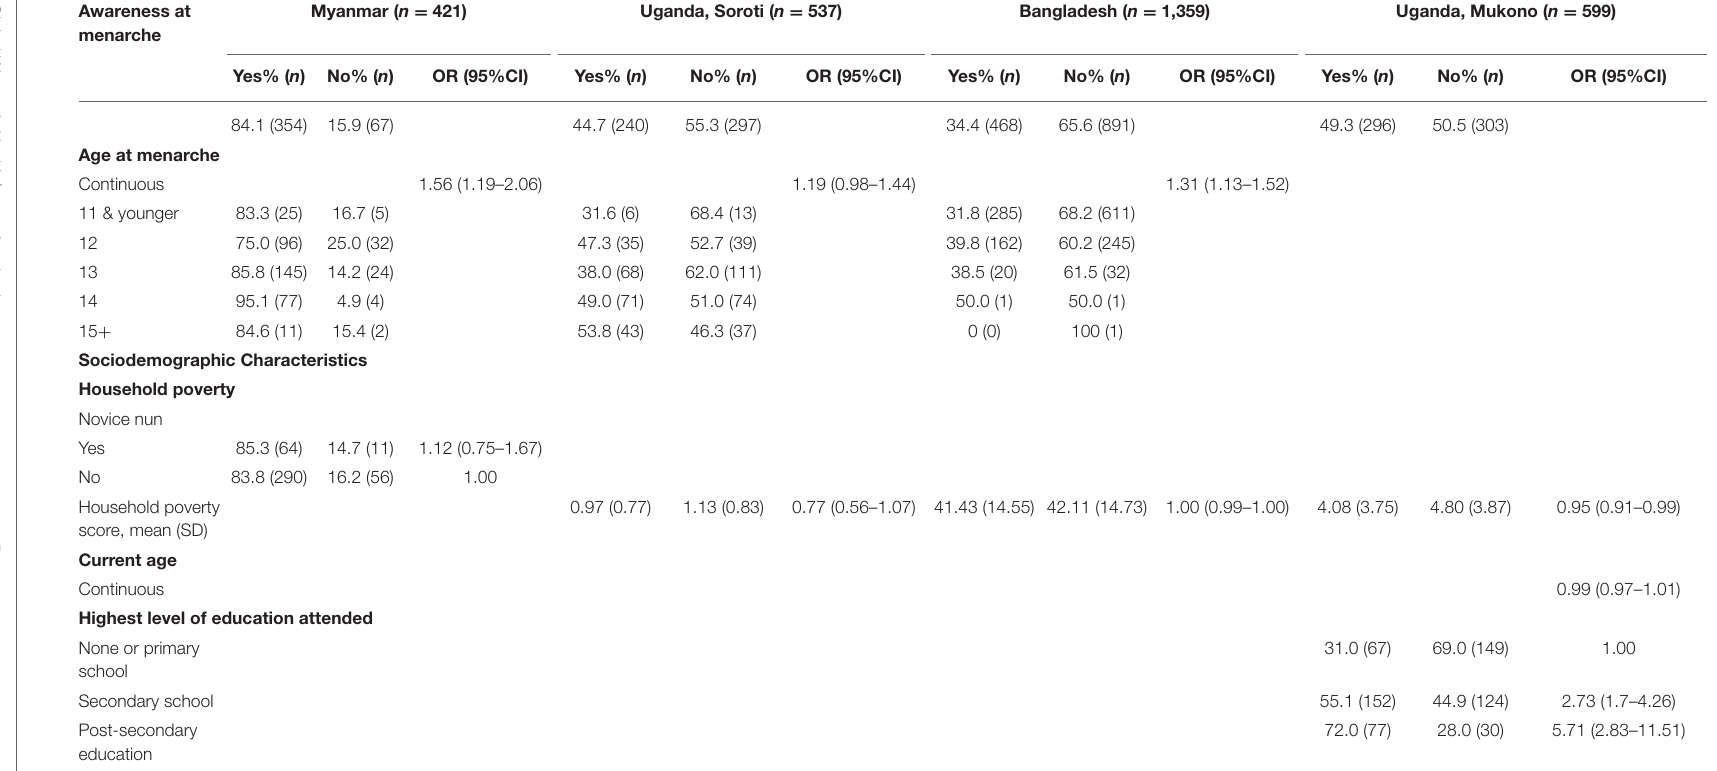
TABLE 2 | Awareness of menstruation at menarche, according to household wealth, age at menarche, and age. Awareness at